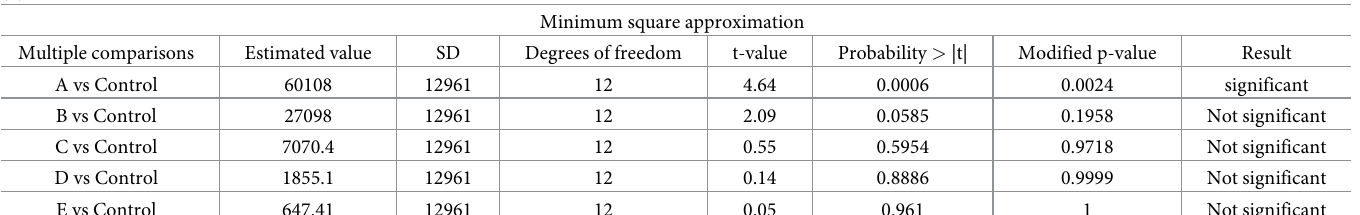
shown in Fig 3. One month following testing, all mice treated with HRIG, NP-19-9, 11B6, or a mAb cocktail (NP-19-9 and 11B6) remained over 90% of survival rate, whereas mice treated with PBS, negative control, developed signs of rabies, varying from 7 to 20 days post infection. The result demonstrated that NP-19-9 and 11B6, and their cocktail effectively neutralized the Indian rabies virus isolates.